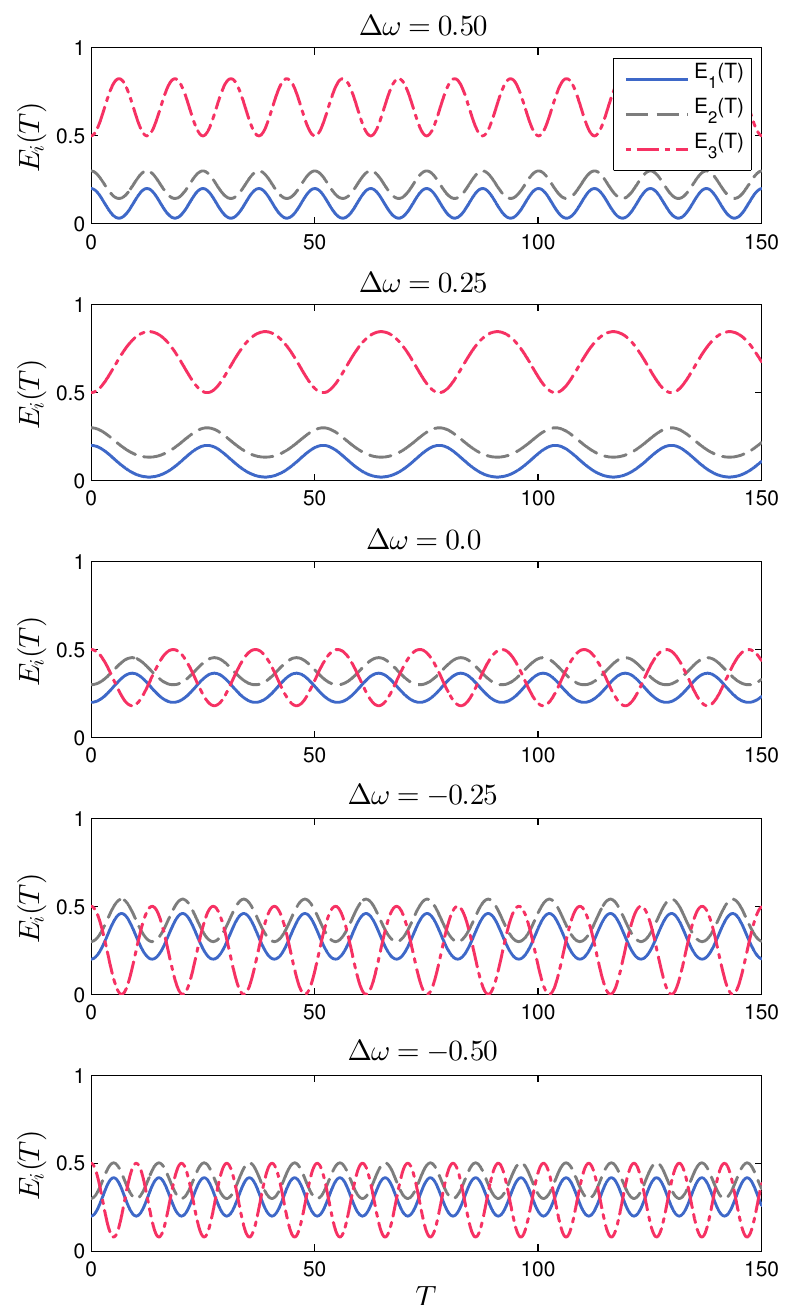
Figure 1. Energy evolution in the triad given in Table 1, for different values of the detuning ∆ ω . The reason to regard these regions separately is that the main characteristics (i.e., energy variation ∆ E , energy oscillation period τ and the phase variation ∆ ψ ) behave differently in each region. Our findings are summarized in Table 2, where all the quantities E , τ and ψ are followed by ± sign denoting the their variation in the region ( + : increase, − : decrease). The first column corresponds to the direction of increasing values of ∆ ω ∈ ( − ∞ → + ∞ ) , while the second column corresponds to the opposite direction ∆ ω ∈ ( − ∞ ← + ∞ )